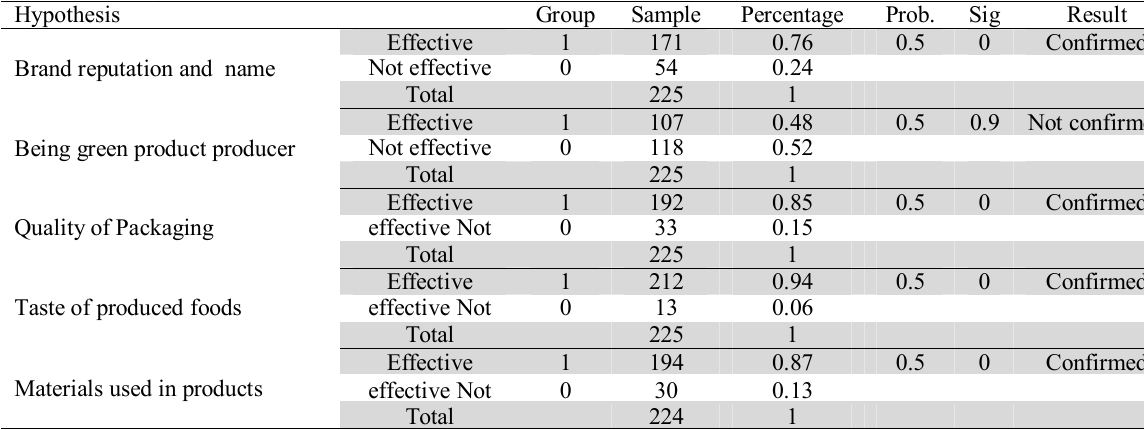
The summary of binomial test